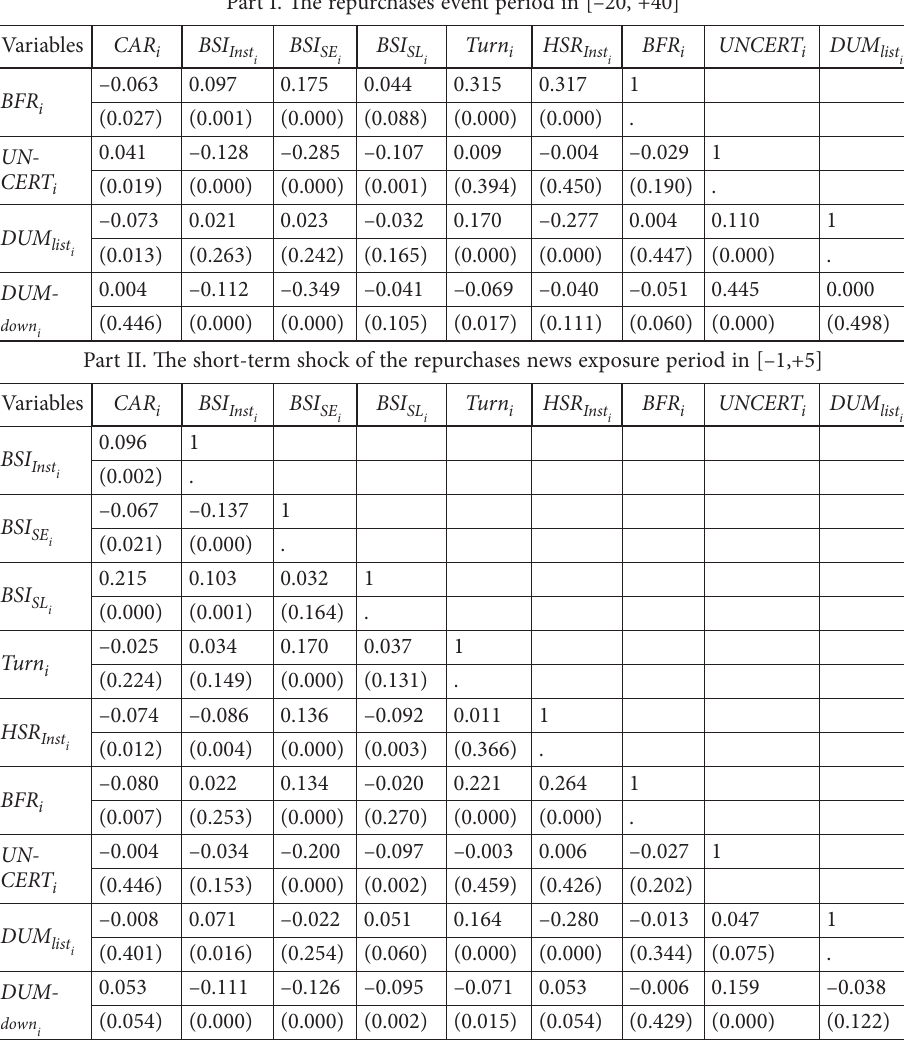
repurchases event period in [–20, +40]) and part II (the short-term shock of the repurchases news exposure period in [–1, +5]). There is a significant correlation between the